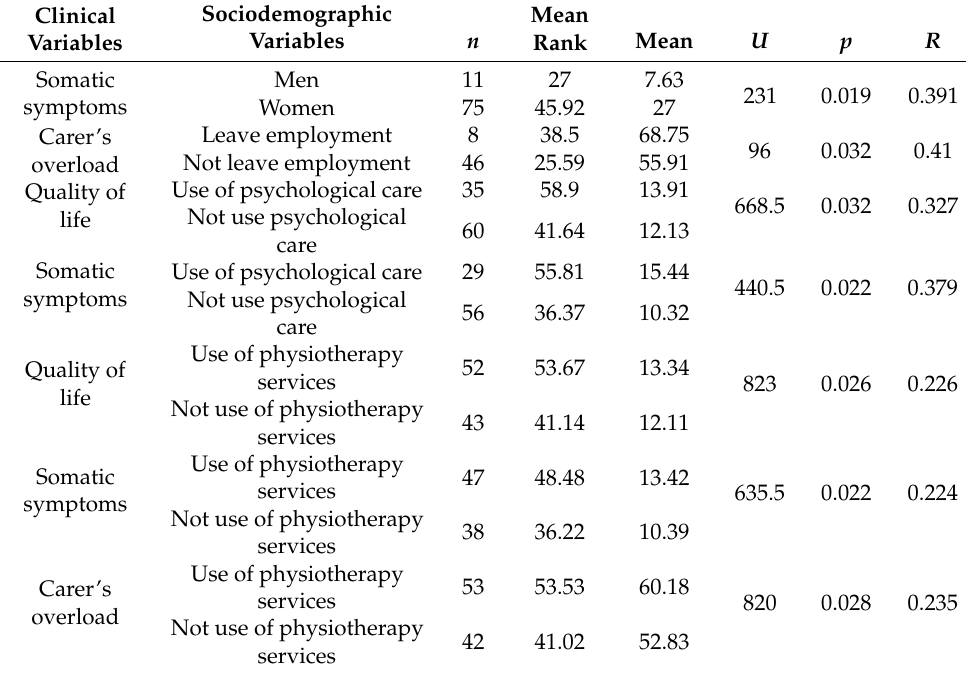
Table 6. Mann–Whitney U test analysis of sociodemographic and clinical variables of the carers ( n =